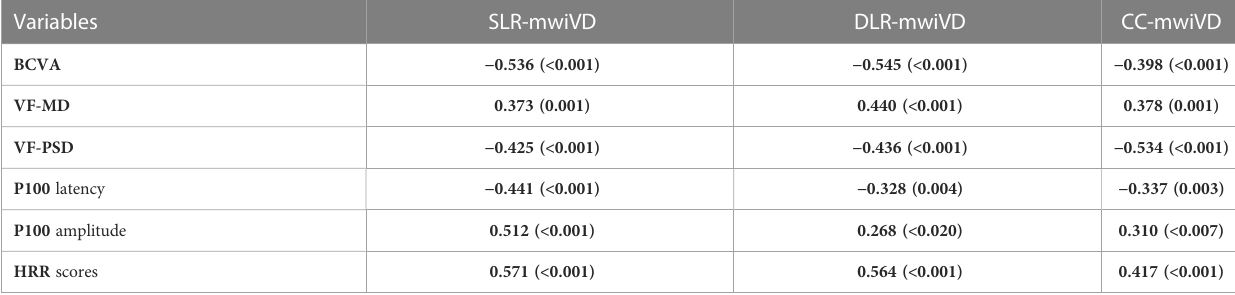
TABLE 4 The correlation between microvascular density and visual function